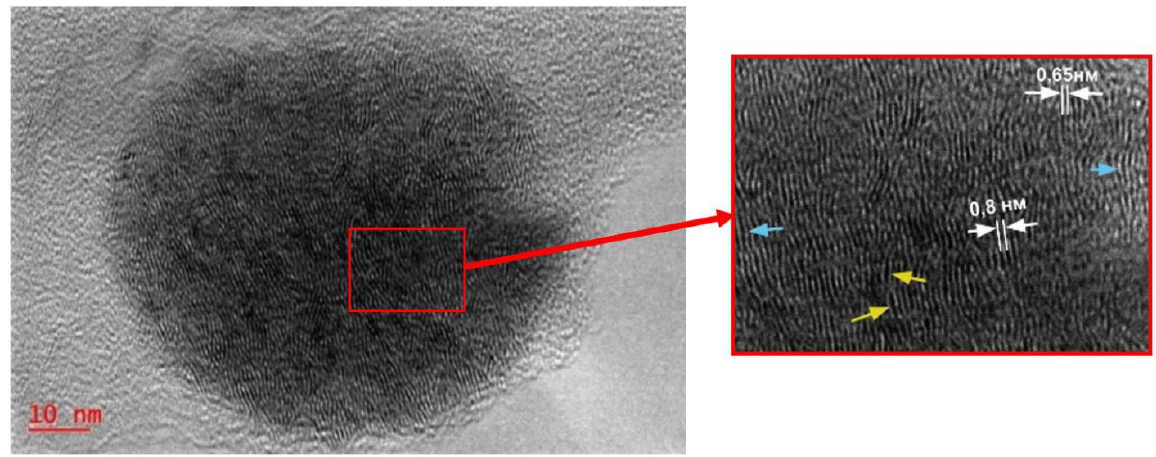
Figure 2. TEM images of nanoparticles with a layered contrast in TI-sample from test #2 (C(Mo) = 0.05wt.%). A translucent matrix that contains more contrasting particles of different For the TI sample from test #1 (C(Mo) = 0.01wt.%, P = 70 atm), the size of non-aggre- gated (isolated) particles lied in the range of 10 nm–1 μ m, which is higher compared with test #2 (C(Mo) = 0.05wt.%). This may be due to the high yield of polycondensation prod- ucts observed in conditions of test #1 (Table 2).